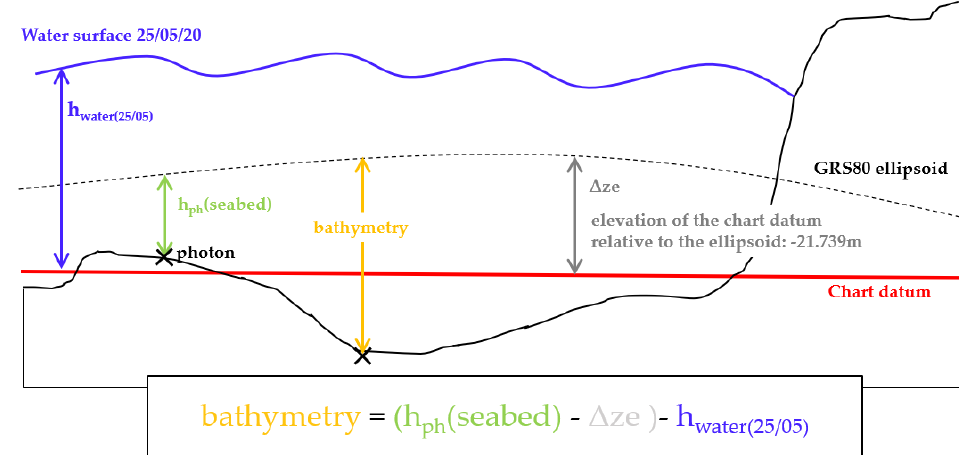
Figure 4. Variables involved in the process of retrieving ICESat-2 bathymetry at the acquisition time of Pleiades-1A.